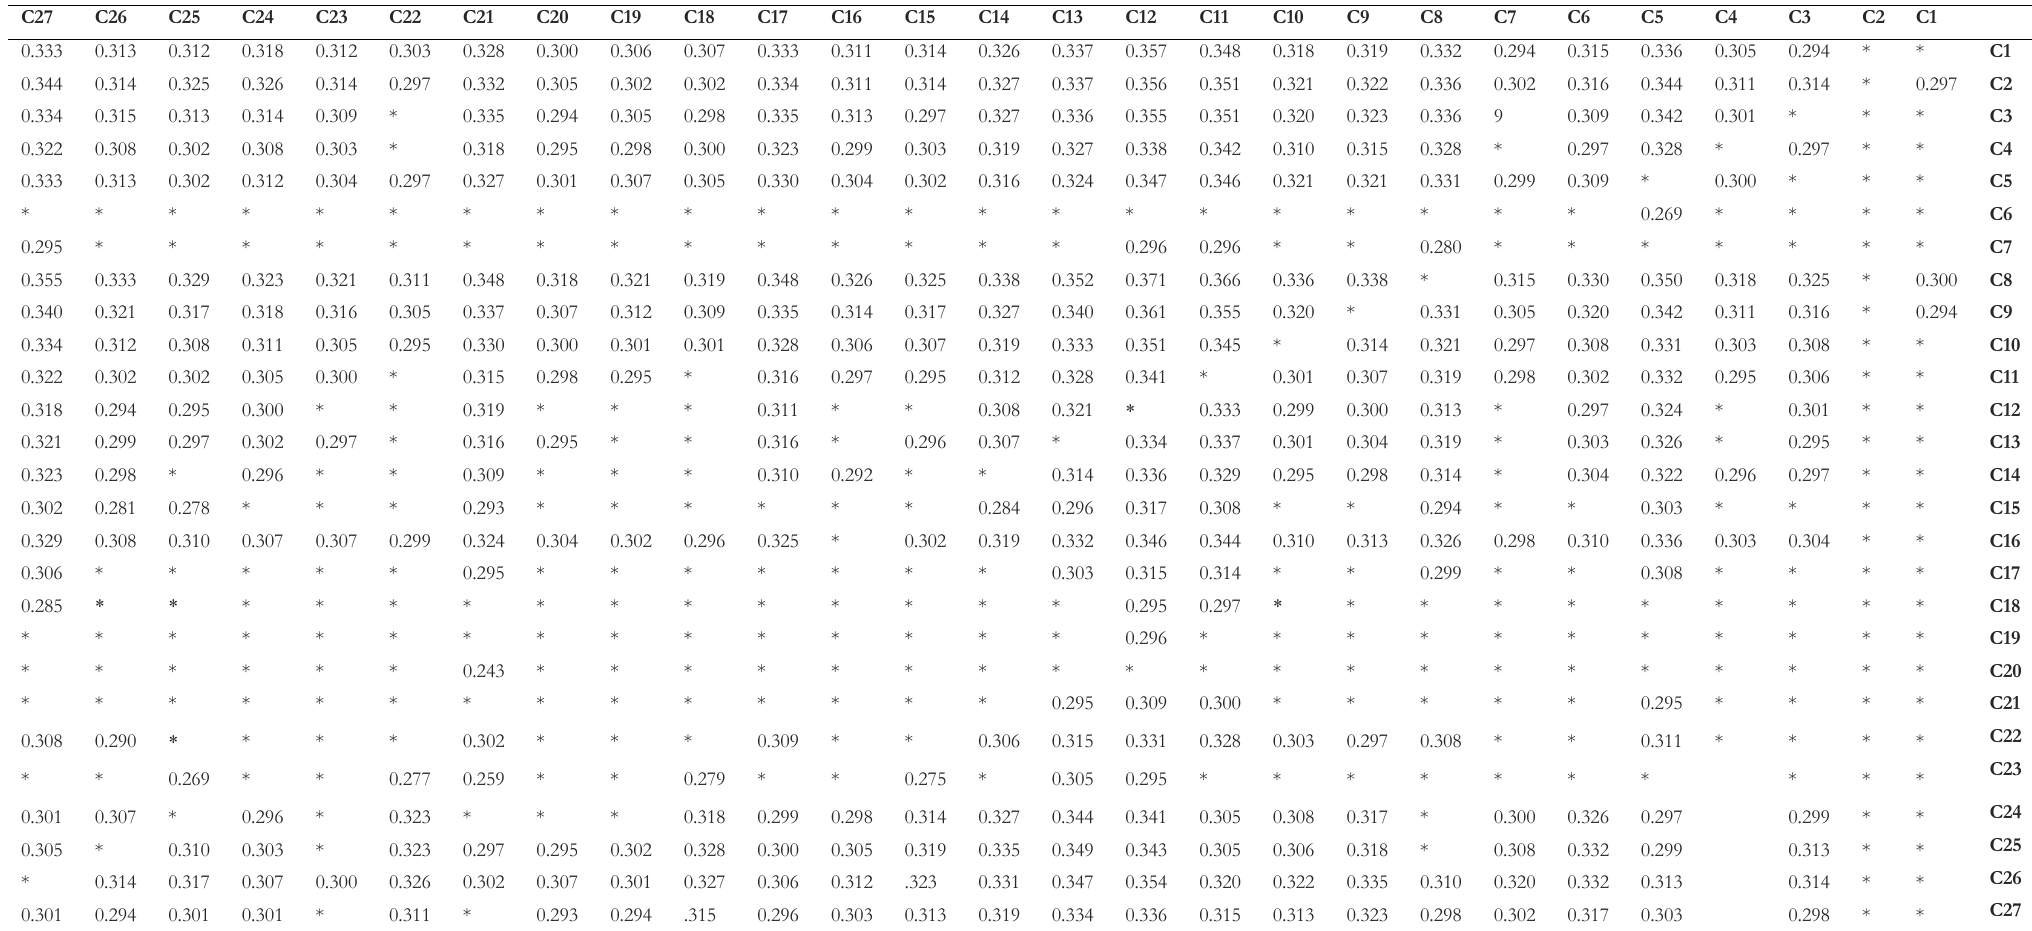
Table 4. Pattern of